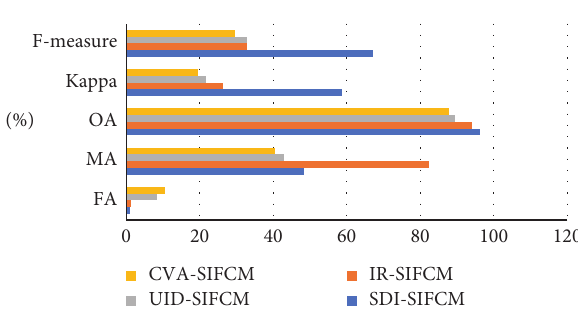
Figure 4: Bar graph of the first group of comparative experimental results of the first group of images.